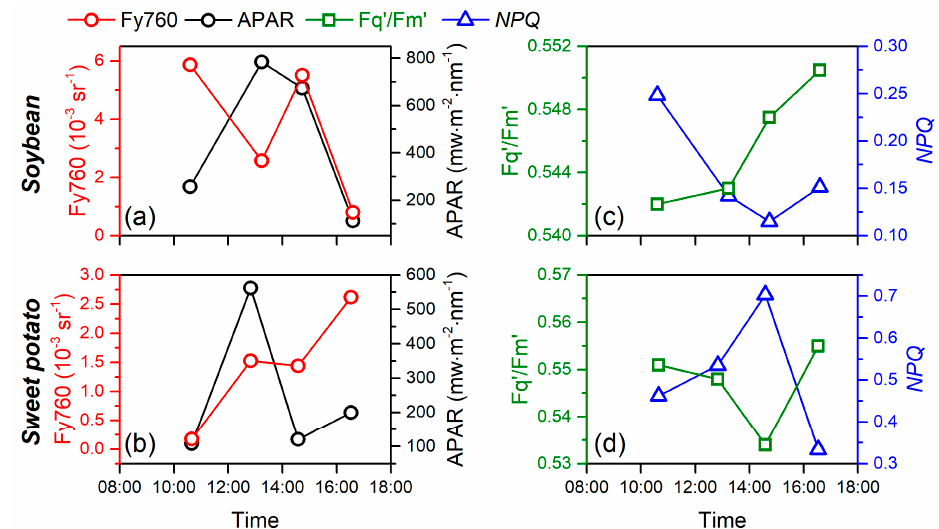
′ /(cid:1832) ′ ′ /(cid:1832) ′ ) accompanied by NPQ in soybean ) accompanied by NPQ in soybean (cid:3044) (cid:3040) (cid:3044) (cid:3040)